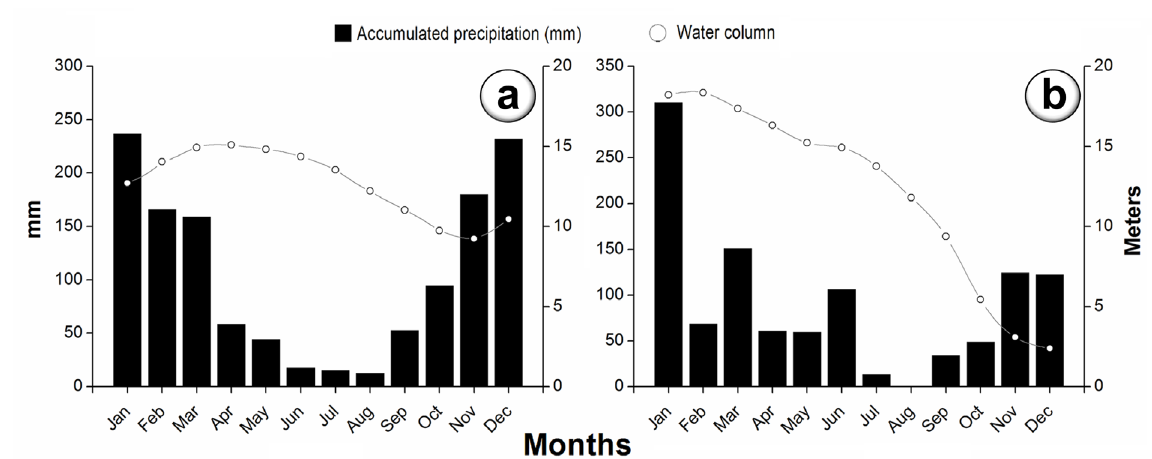
Figure 3. a. Accumulated precipitation and water column mean values from 2000 to 2015, and b. absolute values from 2012 for the Sapucaí River inserted at Furnas HPS